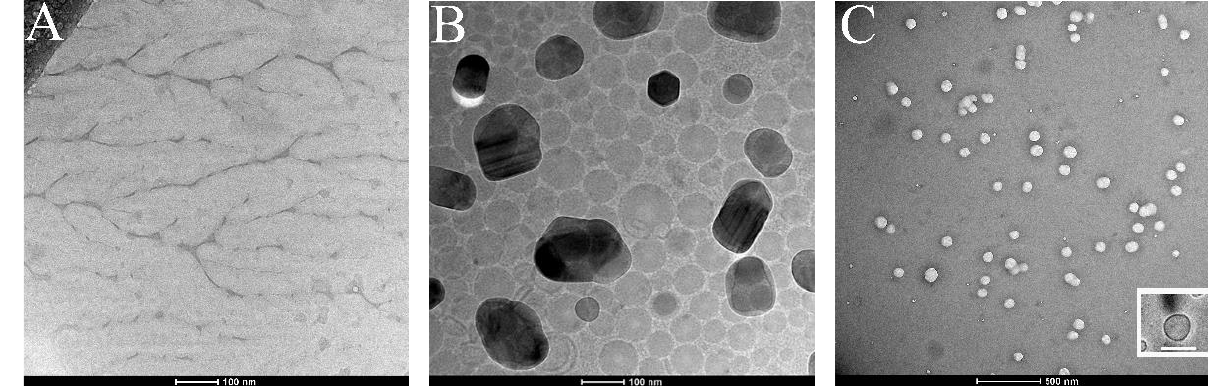
Figure 3. Cryo-TEM images of ( A ) purified cell membrane, ( B ) Ct-NE and ( C ) CM-NESoSome. Inset in panel C shows a single CM-NESoSome at higher magnification. Scale bar 100 nm.